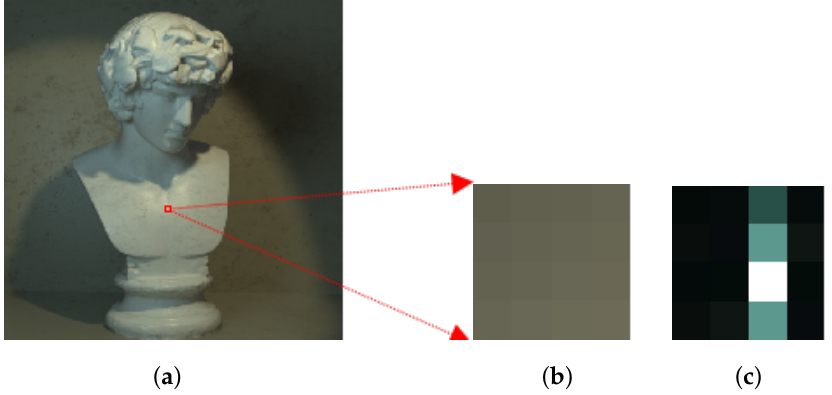
Figure 4. ( a ) Central sub-aperture image of a LF image, ( b ) a magnified 4 × 4 RGB image patch and ( c ) FFT of the image patch.